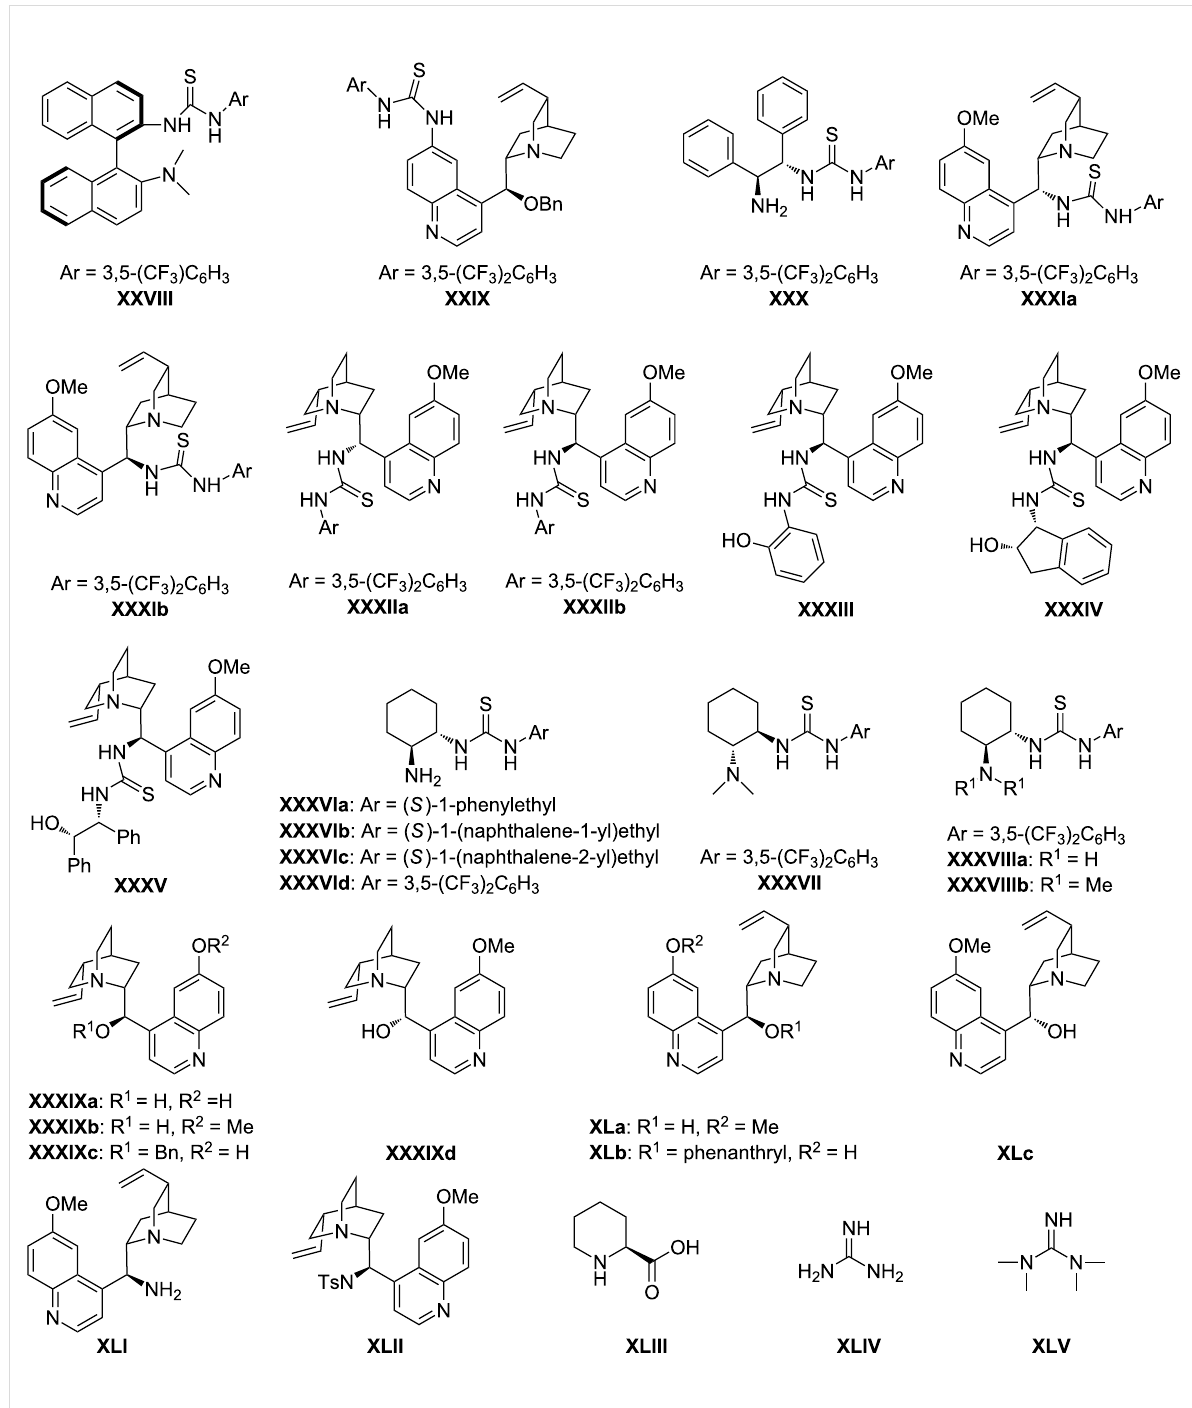
Figure 3: Screened chiral bifunctional thiourea, its derivatives, cinchona alkaloids and other organocatalysts.